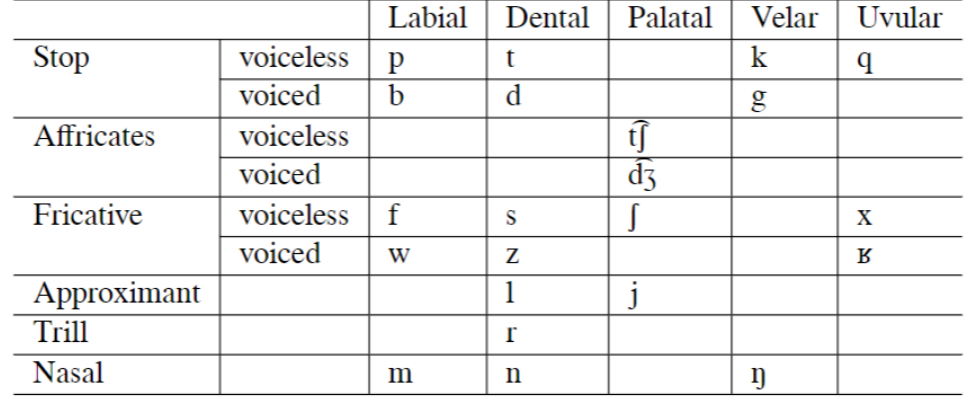
Figure A6. Kyrgyz consonants.